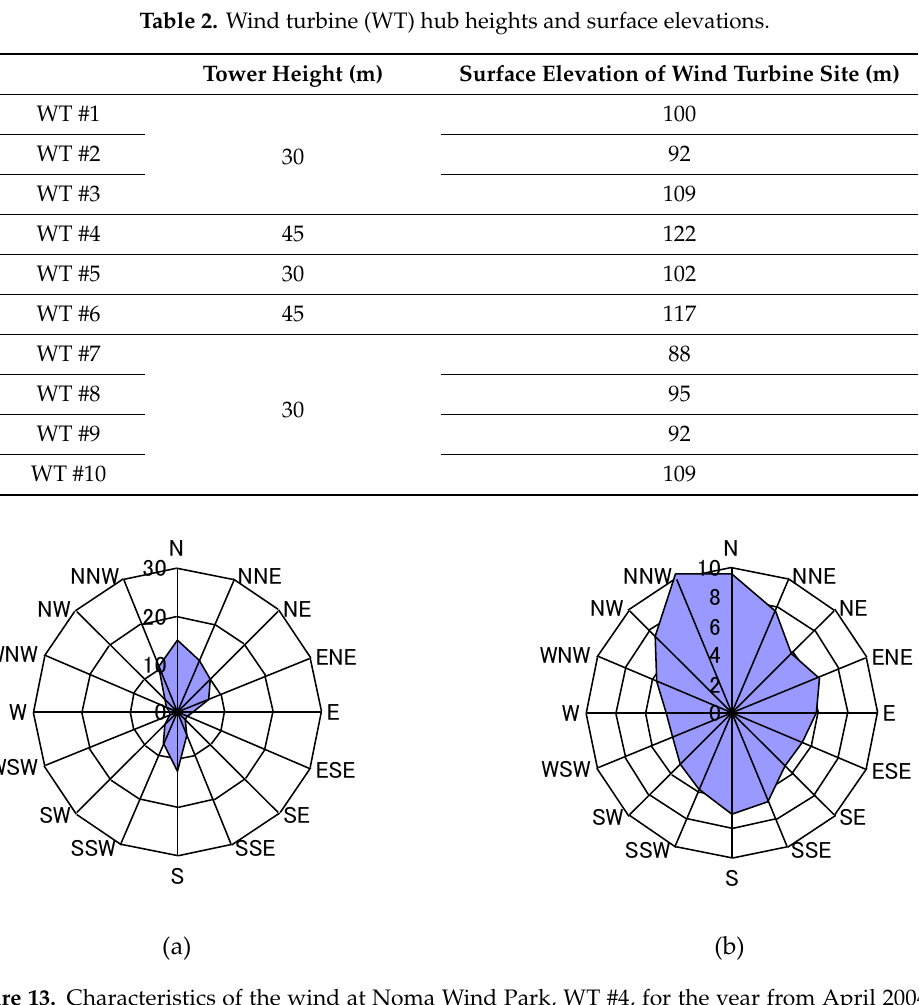
Figure 13. Characteristics of the wind at Noma Wind Park, WT #4, for the year from April 2004 to March 2005: (a) Occurrence frequency (%) and (b) annual average wind speed (m/s). The time-series data interval used to construct the plots was 1 minute.